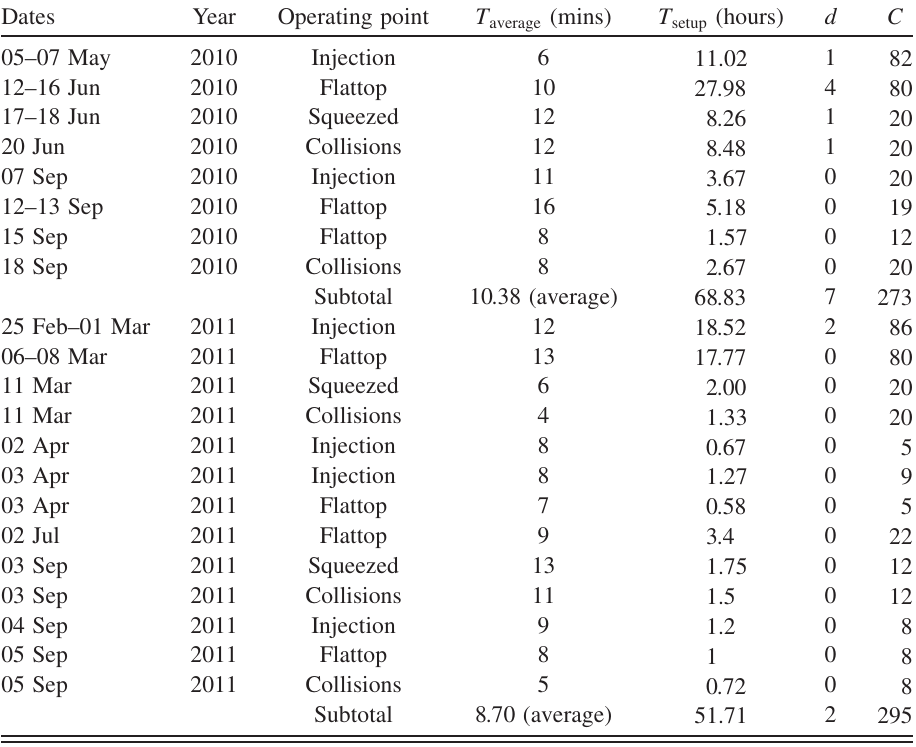
TABLE VII. Comparison of setup times, number of beam dumps d , and collimators aligned C in 2010 and